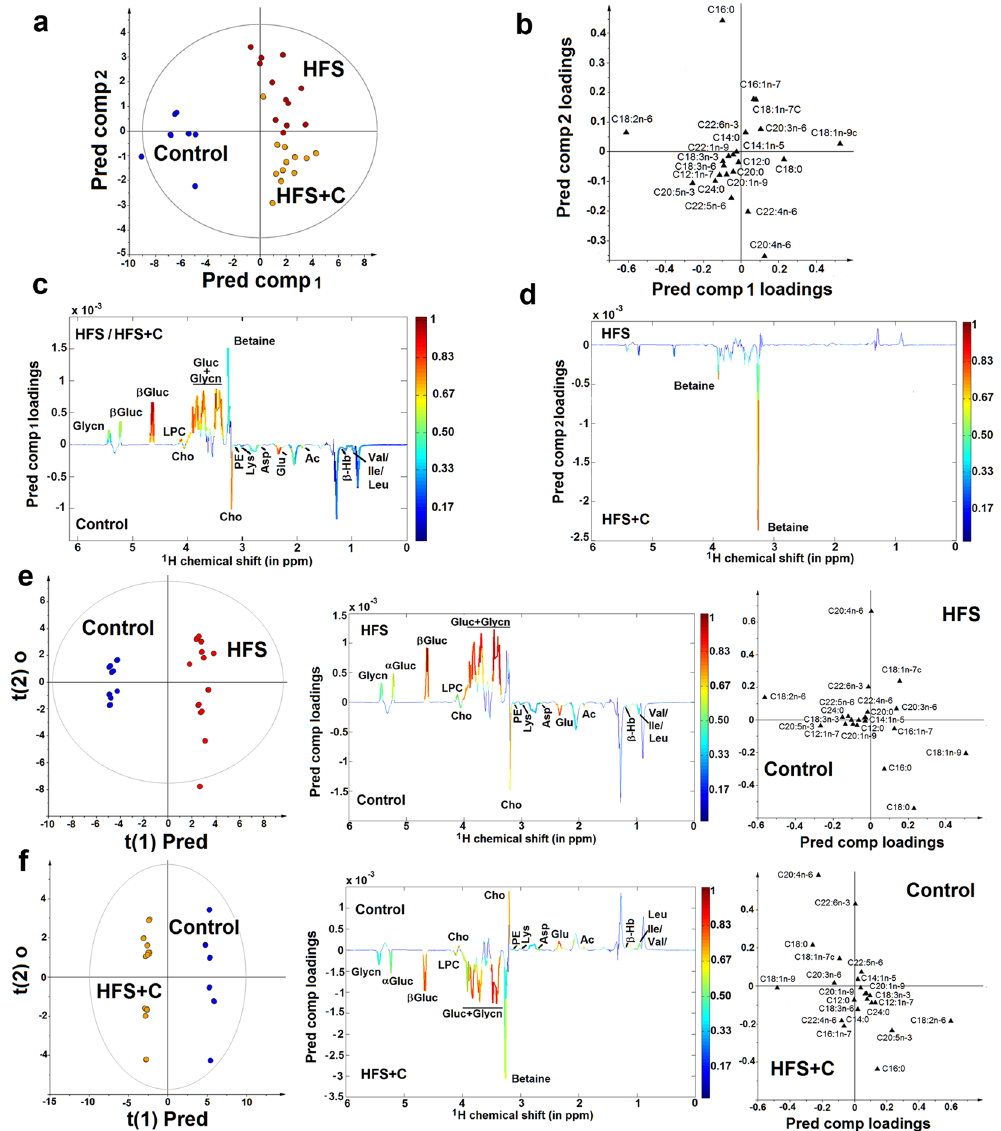
Figure 2. OPLS-DA score and loadings plots. ( a ) OPLS-DA score plot for Control, HFS and HFS + C groups. ( b , c , d ) OPLS-DA loadings plot representing the weights of the relative fatty acid contents and the NMR signals, respectively, along the two predictive components derived from OPLS-DA model of liver samples obtained from controls, HFS and HFS + C groups. OPLS-DA score and loadings plots representing the weights of the NMR signals and the relative fatty acid contents, along the predictive component derived from OPLS-DA models of liver samples obtained from ( e ) control and HFS groups, ( f ) control and HFS + C groups. The positive or negative phase of the resonance signals represents the relative concentration variation of metabolites derived from the covariance matrix. Signals from NMR data are color-coded according to their weights related to the correlation between the X and Y matrices, with red corresponding to highly correlated (r > 0.8) and blue (r < 0.2) indicating no correlation with sample class. Metabolites significantly discriminant were annotated on the model coefficient plot. Abbreviations: Ac = acetate, Asp = aspartic acid, β -Hb = β -hydroxybutyrate, Cho = choline, Glu = glutamate, Gluc = Glucose, Glycn = glycogene, Ile = Isoleucine, Leu = leucine, LPC = Lysophosphatidylcholine, Lys = lysine, PE = Phosphatidylethanolamine, Val =